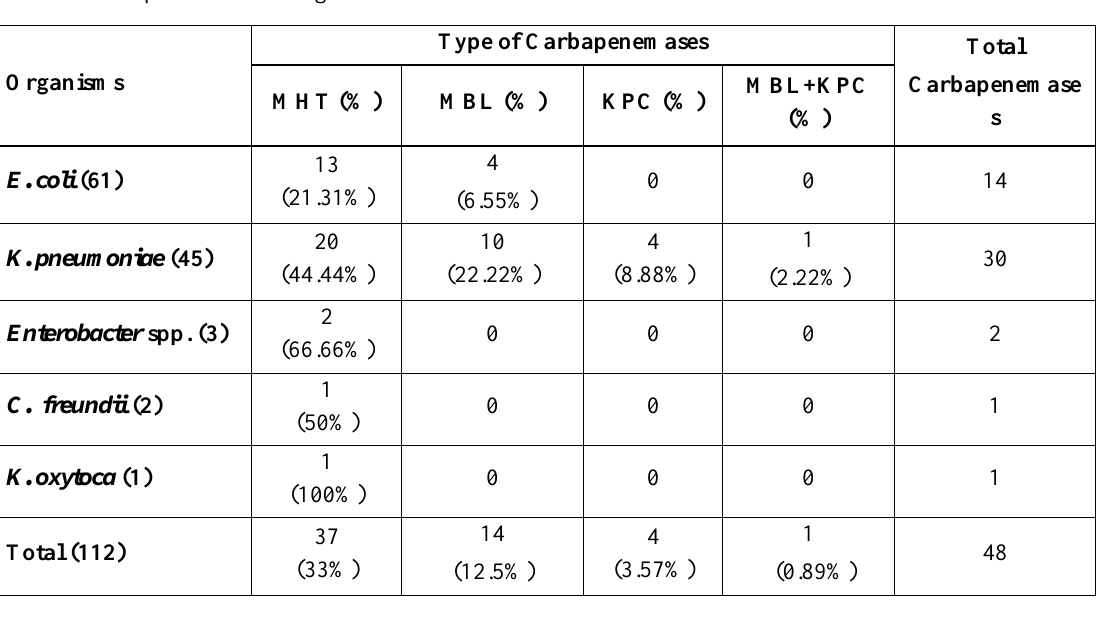
Table 3. Carbapenemases among Enterobacteriaceae .